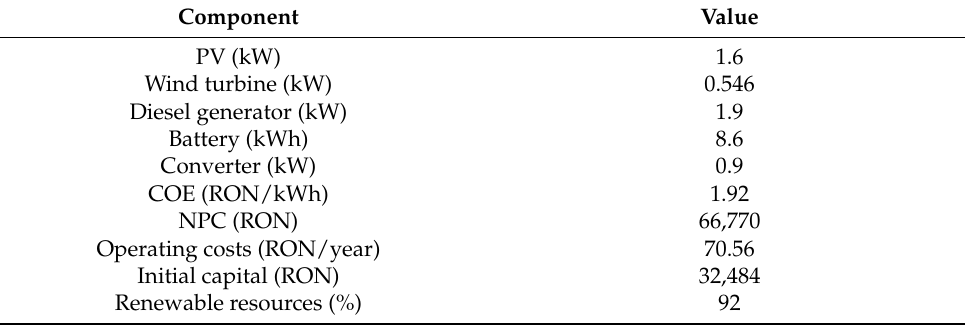
Table 7. The simulation results using iHOGA simulator.